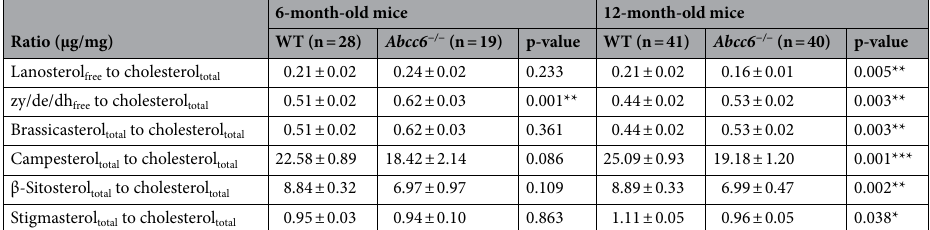
Table 1. Elevated cholesterol precursor to cholesterol ratios and reduction of relative plant sterol levels in Abcc6 knockout mice. Ratios of free cholesterol precursors [lanosterol and zymosterol/desmosterol/7- dehydrocholesterol (zy/de/7dhc)] and total phytosterols (brassicasterol, campesterol, β-sitosterol, stigmasterol) to total cholesterol (μg/mg ± SD) in serum of 6- and 12-month-old WT and Abcc6 −/− mice. Student’s t test;